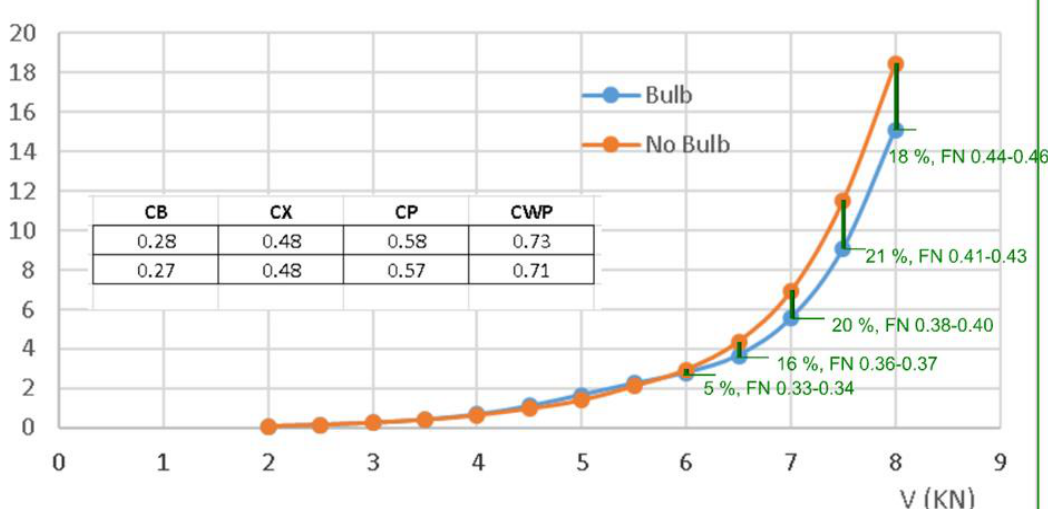
Figure 17. Power reduction for FAO1 vs. FAO2, heavy conditions.